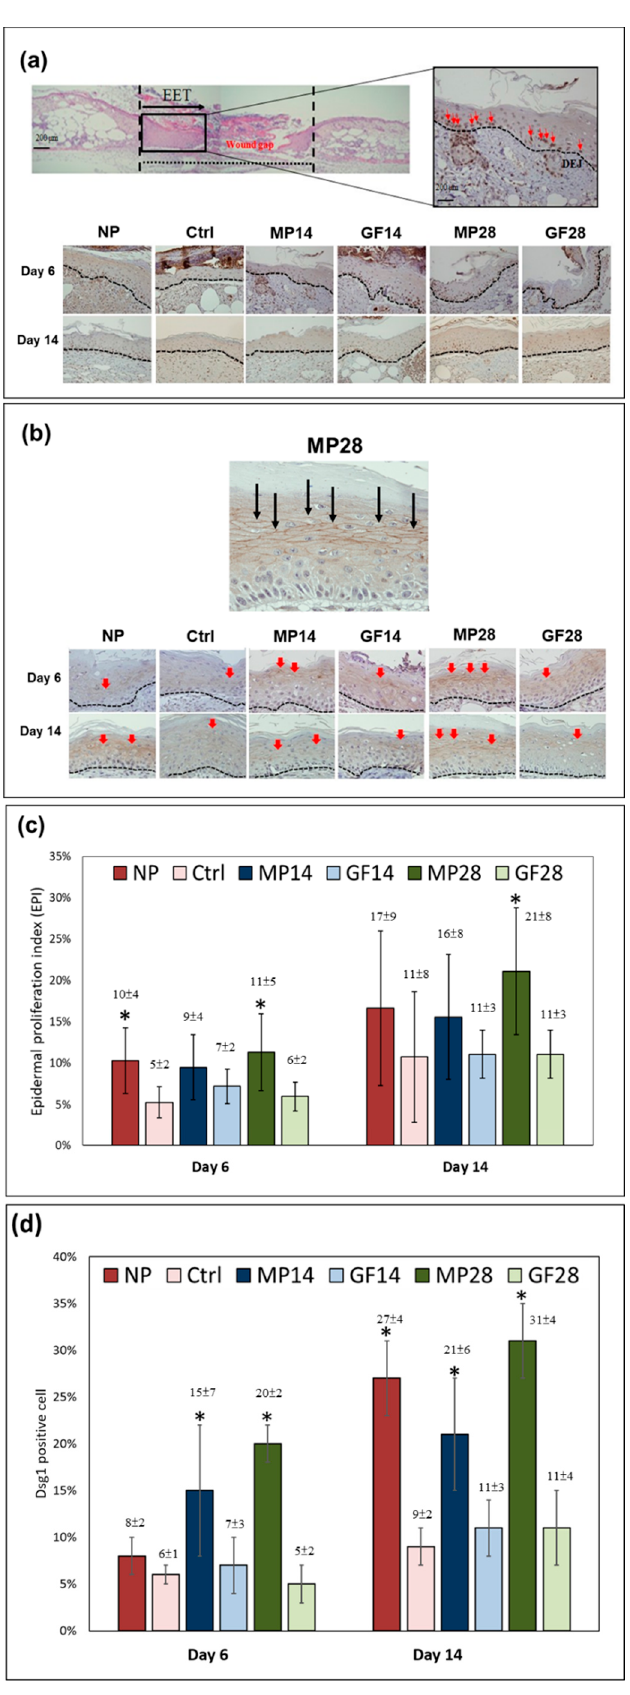
Figure 4. Immunohistochemical stain of Ki67 and DSG1 in the EET of the NP, control, MP14, GF14, MP28, and GF28 groups on days 6 and 14: ( a ) Representative images of Ki67 staining localized in